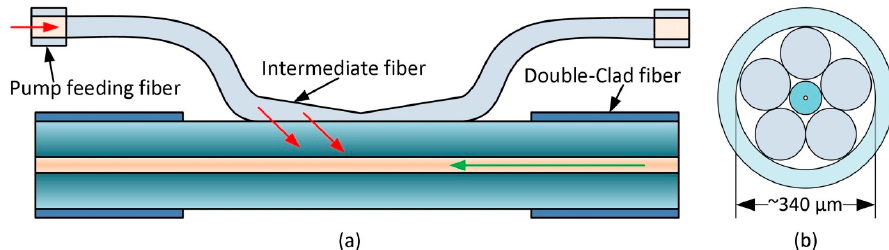
Figure 6. Scheme of the side-pump power combiner adapted from a paper [64] ( a ) and the cross sectional area of (5 + 1) × 1 power combiner adapted from our previous work [65] ( b ).